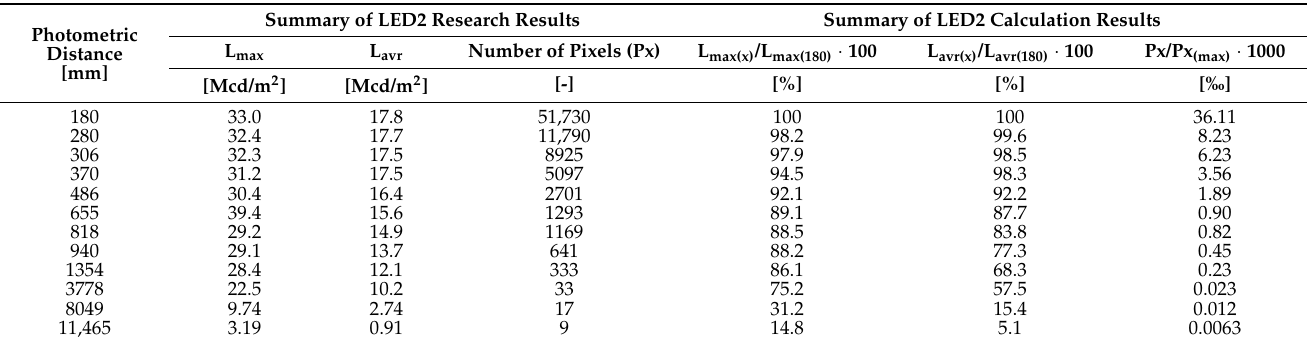
Table 4. The summary of test results and calculations, the effect of varying the photometric distance on the maximum and mean luminance results for LED2.